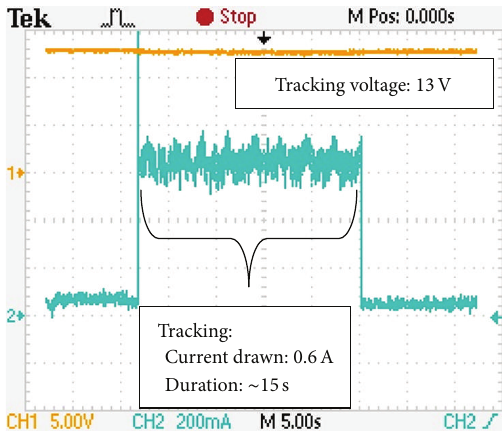
Figure 10: The voltage of the tracking system, 𝑉 , during the tracking drawn, 𝐼 drawn